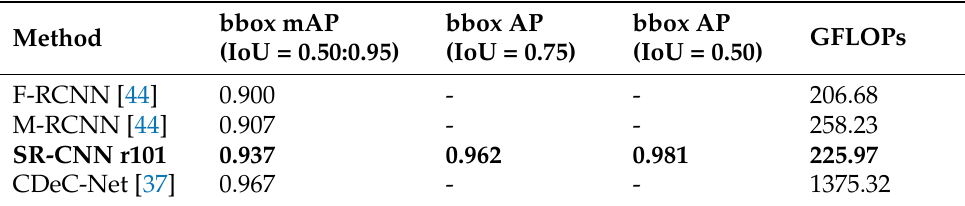
Table 10. The results of the SR-CNN model on the PubLayNet [44] dataset, along with the comparison with other state-of-the-art methods.